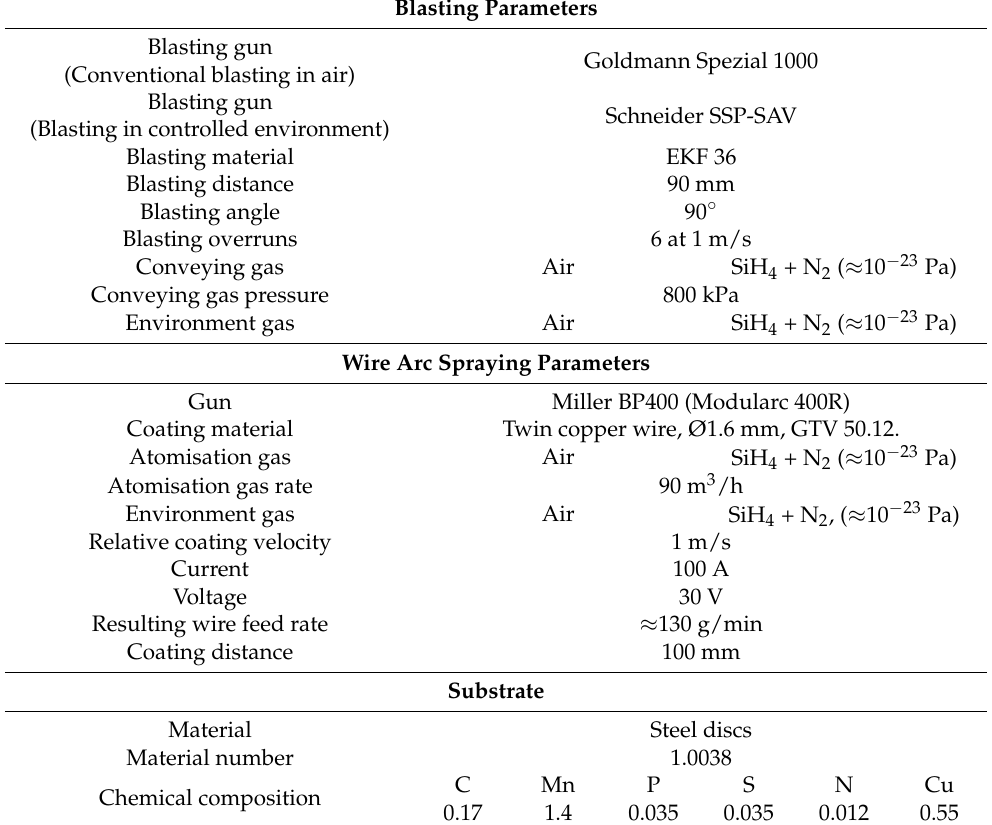
Table 1. Process parameters used for the blasting and wire arc spraying